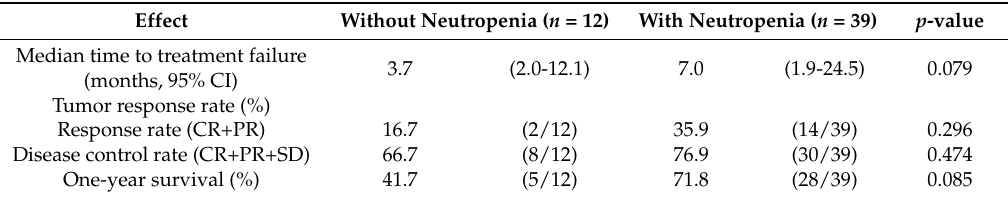
Table 3. Comparison of the median time to treatment failure and tumor response rate between patients with grade ≥ 3 neutropenia and those without it after treatment with modified FOLFIRINOX for advanced pancreatic cancer.